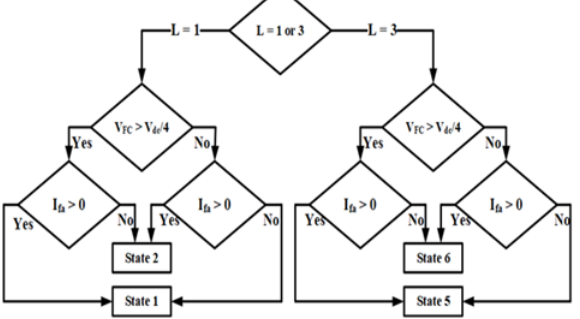
Fig.2. Switching selection